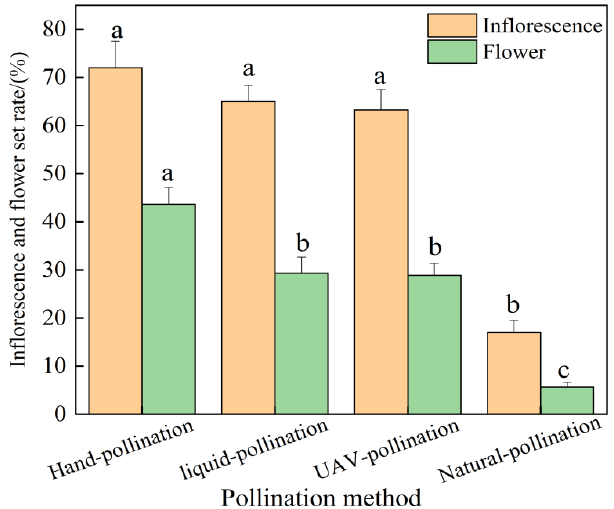
Figure 7. Comparison of fruit setting rates of inflorescence and flowers using different pollination methods. Different lowercase letters indicate significant differences in the same pollination position among different treatments ( p < 0.05).